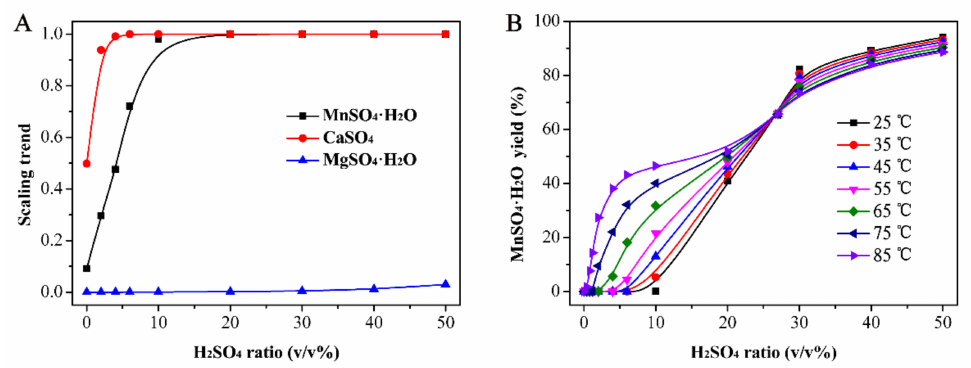
Figure 2. The scaling trend ( A ) of different components of industrial MnSO 4 solution with the addition ratio of H 2 SO 4 and MnSO 4 · H 2 O yield ( B ) in the temperature range of 25–85 ◦